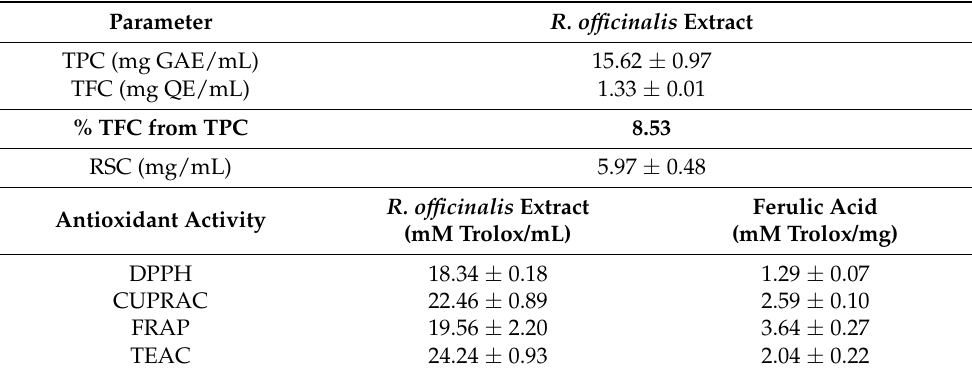
Table 1. The TPC and antioxidant activity obtained by different methods.